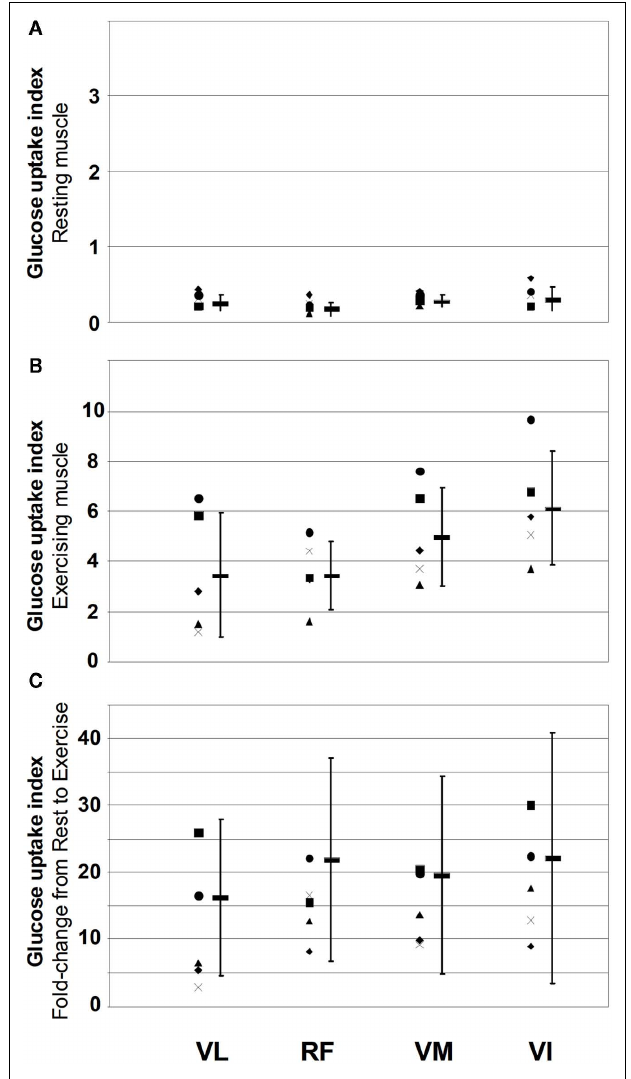
FIGURE 2 | Muscle glucose uptake index at rest (A) and during exercise (B) and the fold-increase in glucose uptake from rest to exercise (C) in the for different quadriceps femoris muscles in the five study subjects. Different symbols on the left-hand side of each muscle depict different subjects and the thick line and error bars depict the mean and SD within each muscle. Muscle abbreviations are: vastus lateralis (VL), rectus femoris (RF), vastus medialis (VM), and vastus intermedius